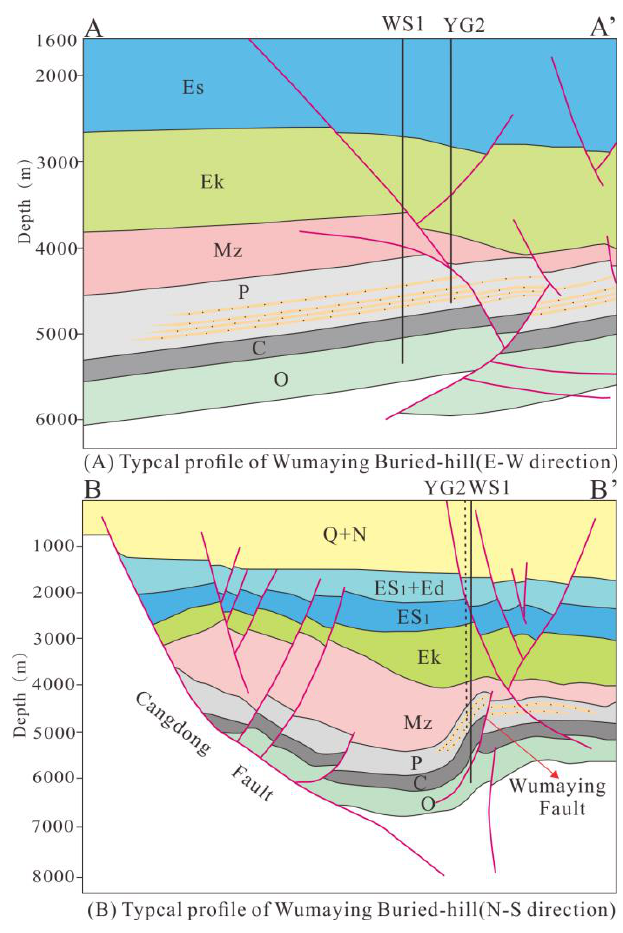
Figure 14. Profile A-A’ and B-B’ in the Wumaying buried hill (refer to Figure 1 for locations of the profiles).